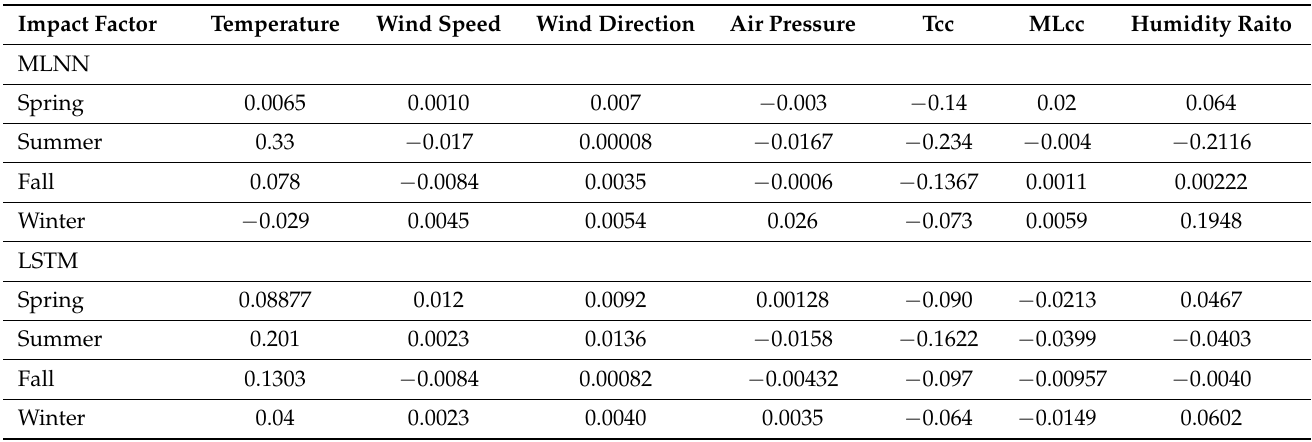
Table 1. Impact factors of input climate elements determined by MLNN and LSTM models in four seasons. Figure 9. Impact factor of input climate elements determined by four methods. Impact